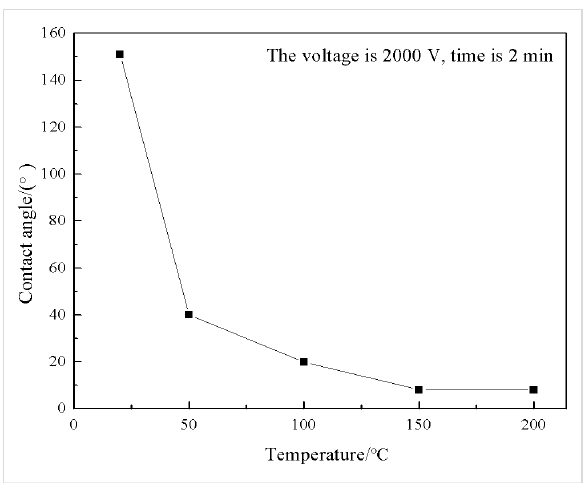
Figure 9: Changes in the contact angle of the coating upon heating (2000 V, 2 min).